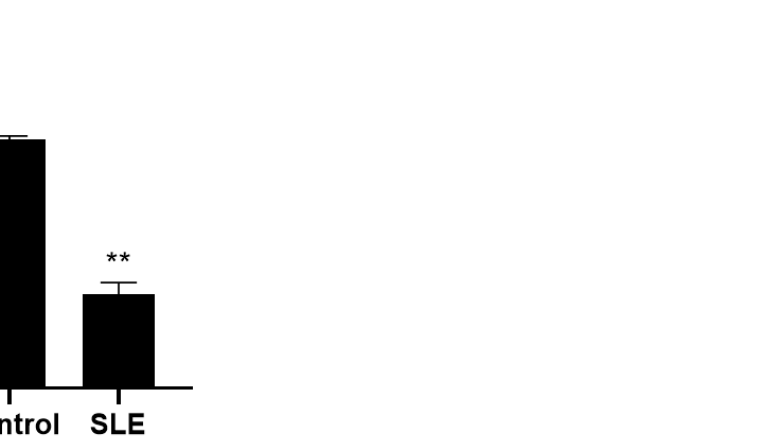
Figure 1. Expression degrees of miR-19b in SLE patients and normal controls. (Compared with the control group, ** P < 0.01)